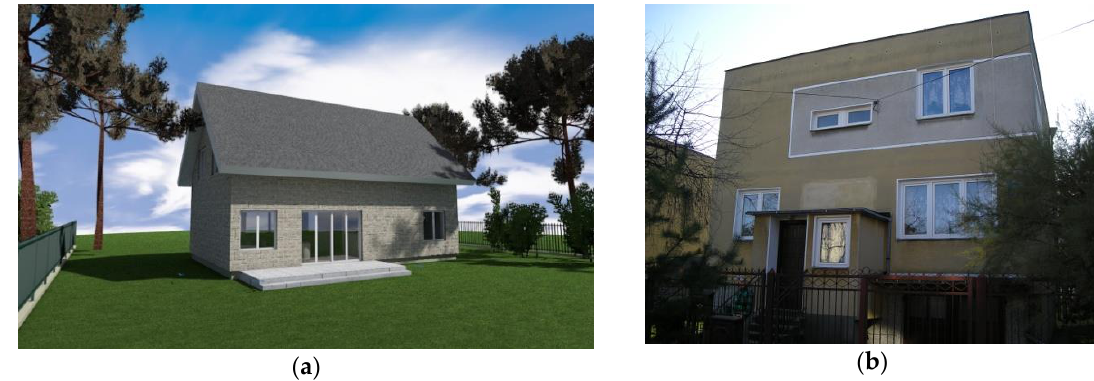
Figure 1. Reference single family house: ( a ) one-storey building with an attic (1-S); and ( b ) two-storey building with flat roof (2-S).